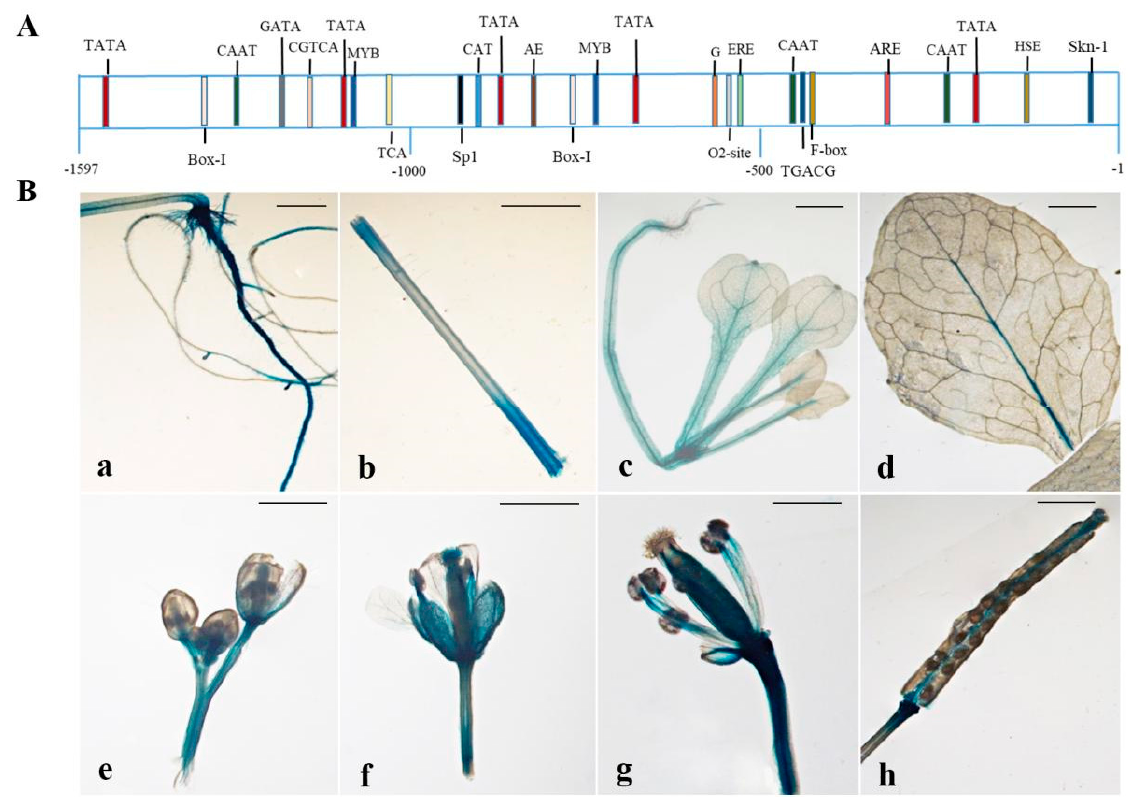
Figure 4. Diagram and the tissue-specific GUS activity of CpSRG1 promoter. ( A ). A diagram of the promoter region of CpSRG1 with potential cis-elements binding sites. ( B ). Tissue-specific GUS activity under the control of the CpSRG1 promoter ( a ) roots, ( b ) stem, ( c ) young leaves, ( d ) senescing leaves, ( e ) young flowers, ( f ) senescing flower, ( g ) column, ( h ) silique. Bars denote 2 mm. Histochemical GUS staining showed that faint GUS activity was observed in the leaves, and strong GUS activity was observed in roots, stem, and flower organs. GUS staining increased from flower buds to senescing flowers. In the mature siliques, GUS staining was mainly detected in the abscission zone and upper portion of the siliques (Figure 4B). This result showed that the tissue expression pattern of the GUS gene driven by the CpSRG1 promoter in Arabidopsis was consistent with the tissue-specific expression pattern of CpSRG1 in wintersweet, with both of them being more highly expressed in senescing flowers than in other tissues. These results were consistent with the expression of CpSRG1 in wintersweet, both of which were most abundantly expressed in senescing